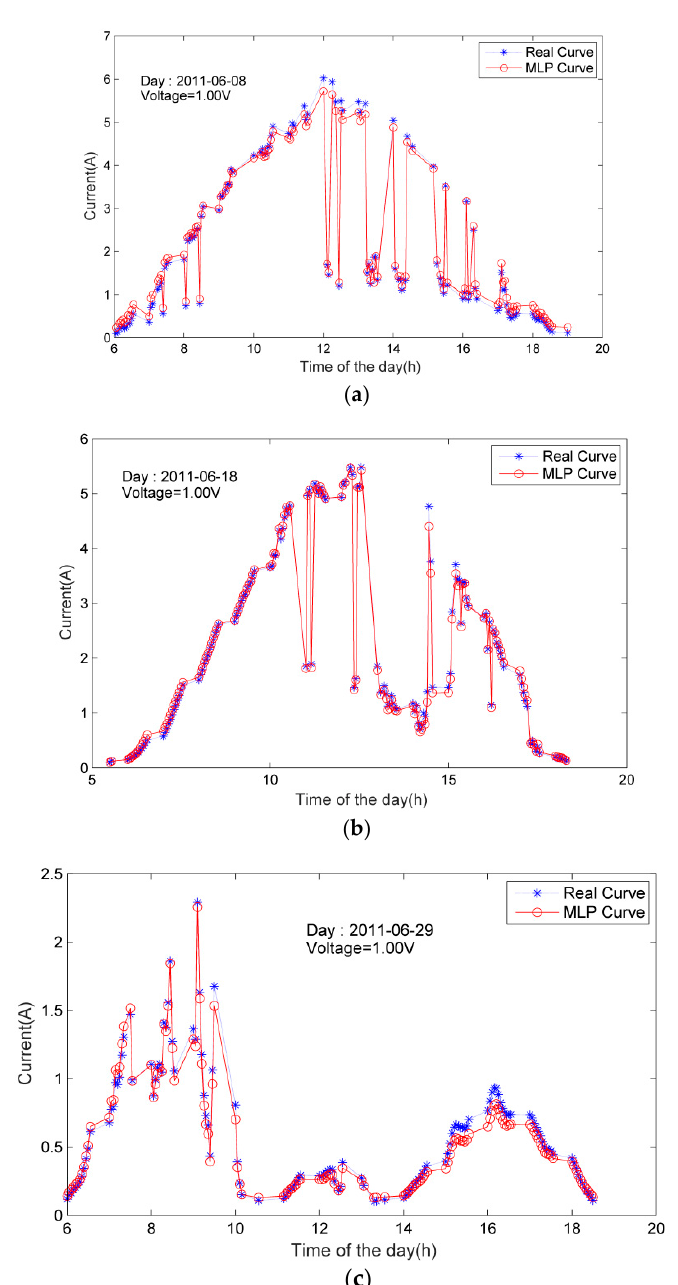
Figure 6. Comparison of the performance prediction results of the PV module on ( a ) 8 June 2011; ( b ) 18 June 2011; ( c ) 29 June 2011.